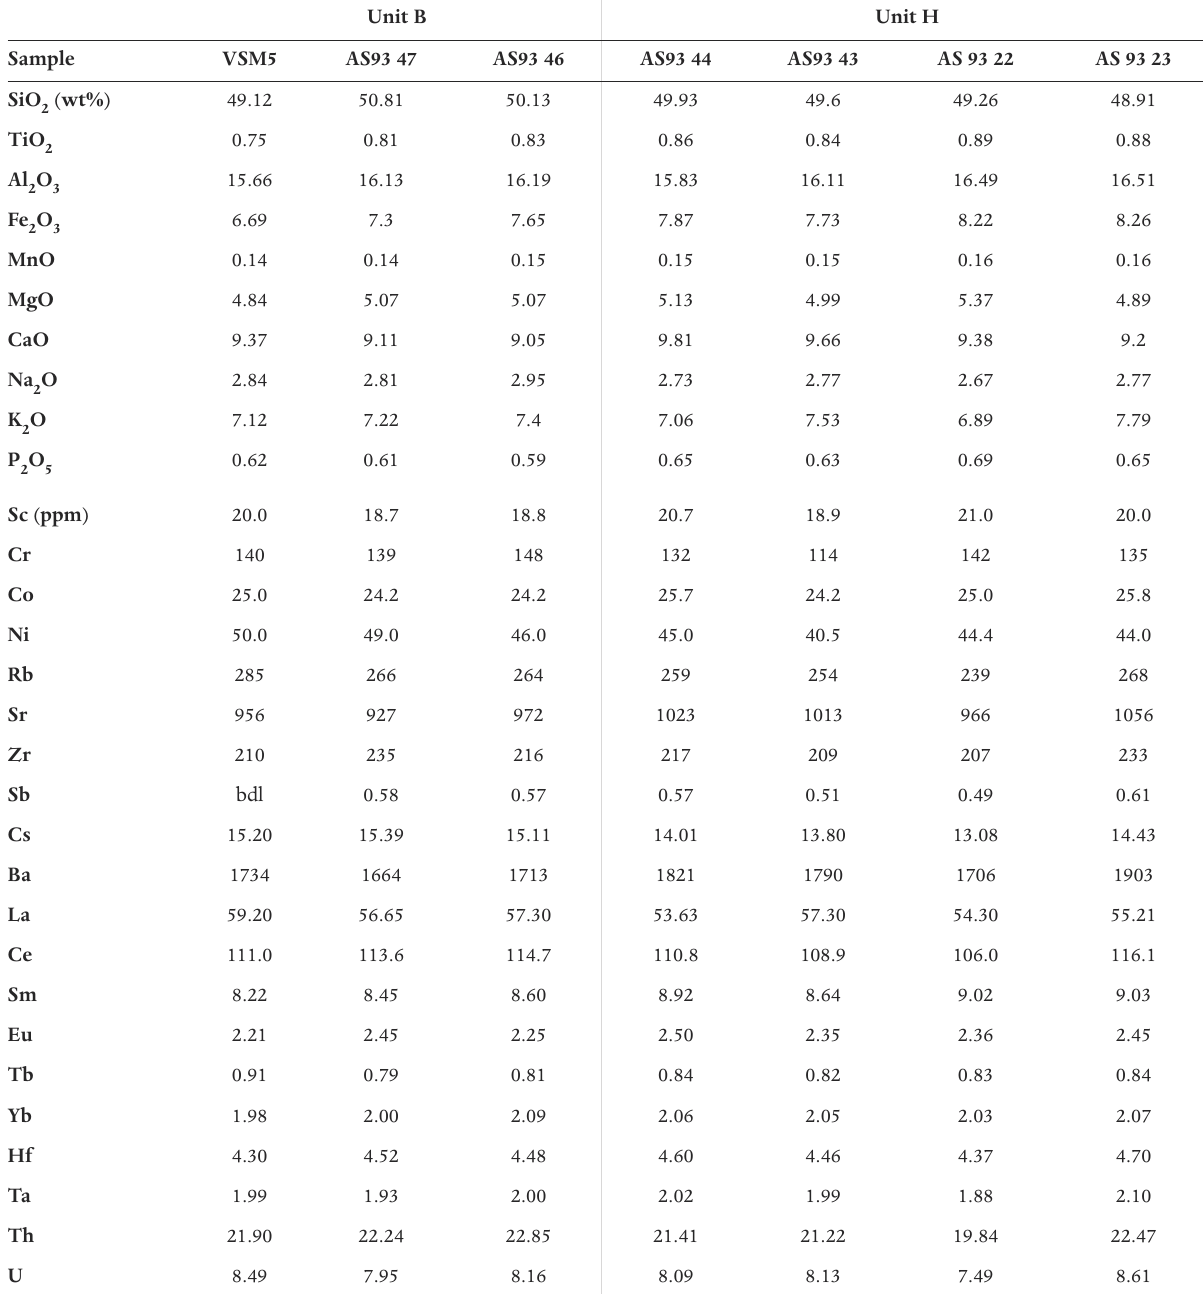
Table 1. Bulk rock compositions of coarse scoriae collected at S1 and S3 from the main lapilli layers. Sample’s position is indicated in Figures